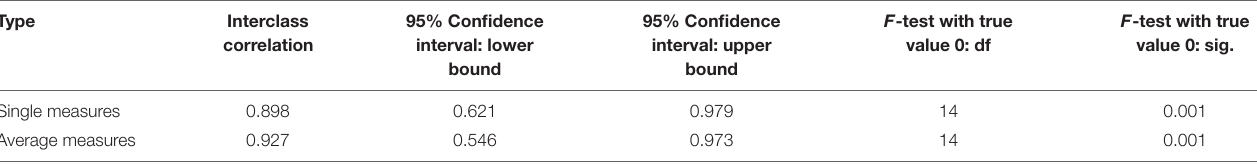
Top row: data for single measures. Bottom row: data for average measures.